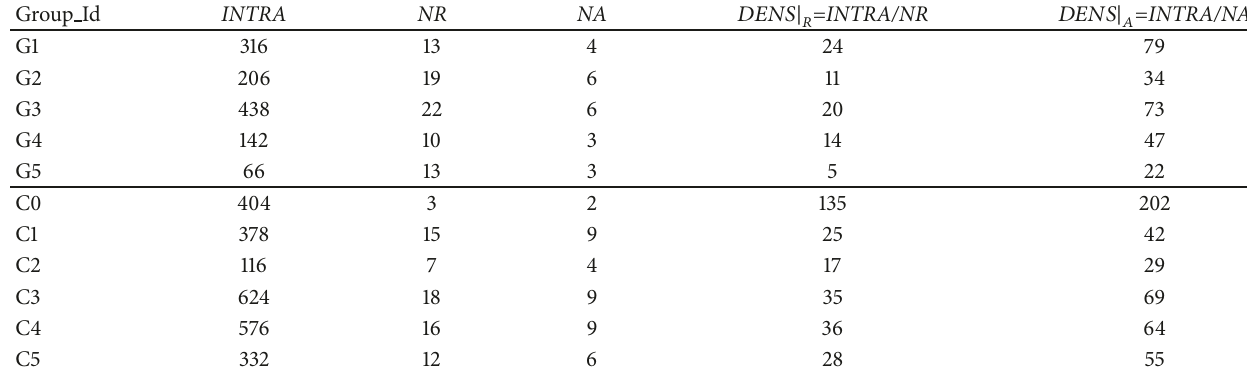
Table 2: Comparison of performance indicators between existing groups and proposed